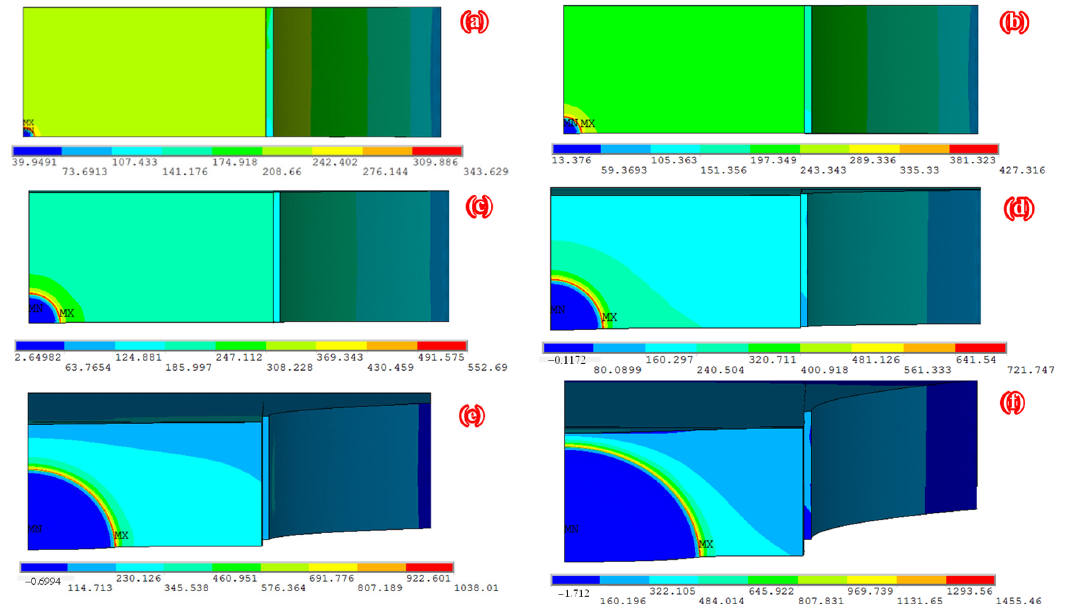
Figure 10. Distribution characteristic of tensile stress along the crack front of the semi ‐ elliptical surface crack of specimen C9 ‐ DS1 ‐ A during partial ‐ through crack propagation stage (unit: MPa): ( a ) step 1, ( b ) step 3, ( c ) step 6, ( d ) step 10, ( e ) step 15 and ( f ) step 20.